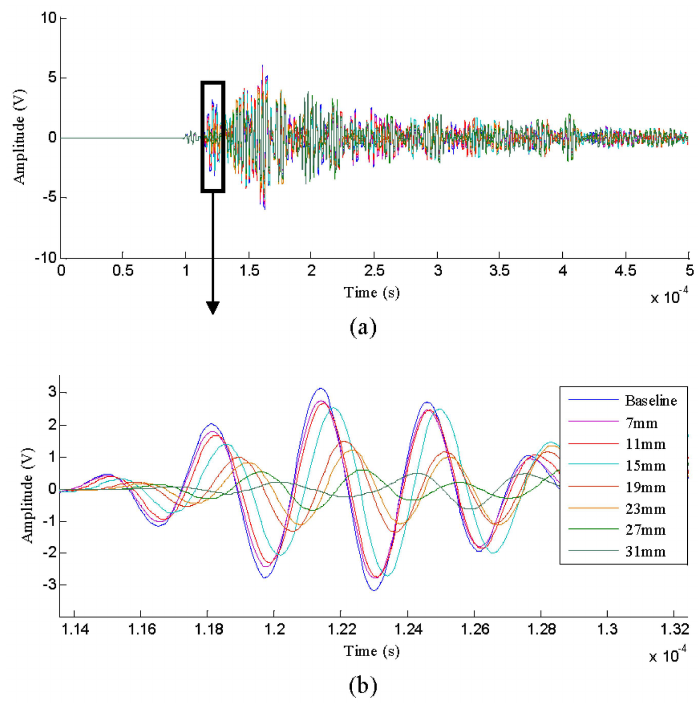
Figure 8. The typical Lamb wave signals of specimen T 1 : ( a ) Whole signal; ( b ) Local